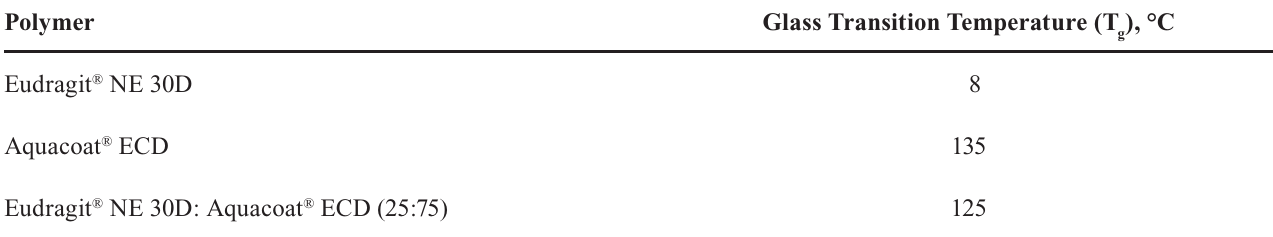
TABLE I - Glass transition temperature (T ECD